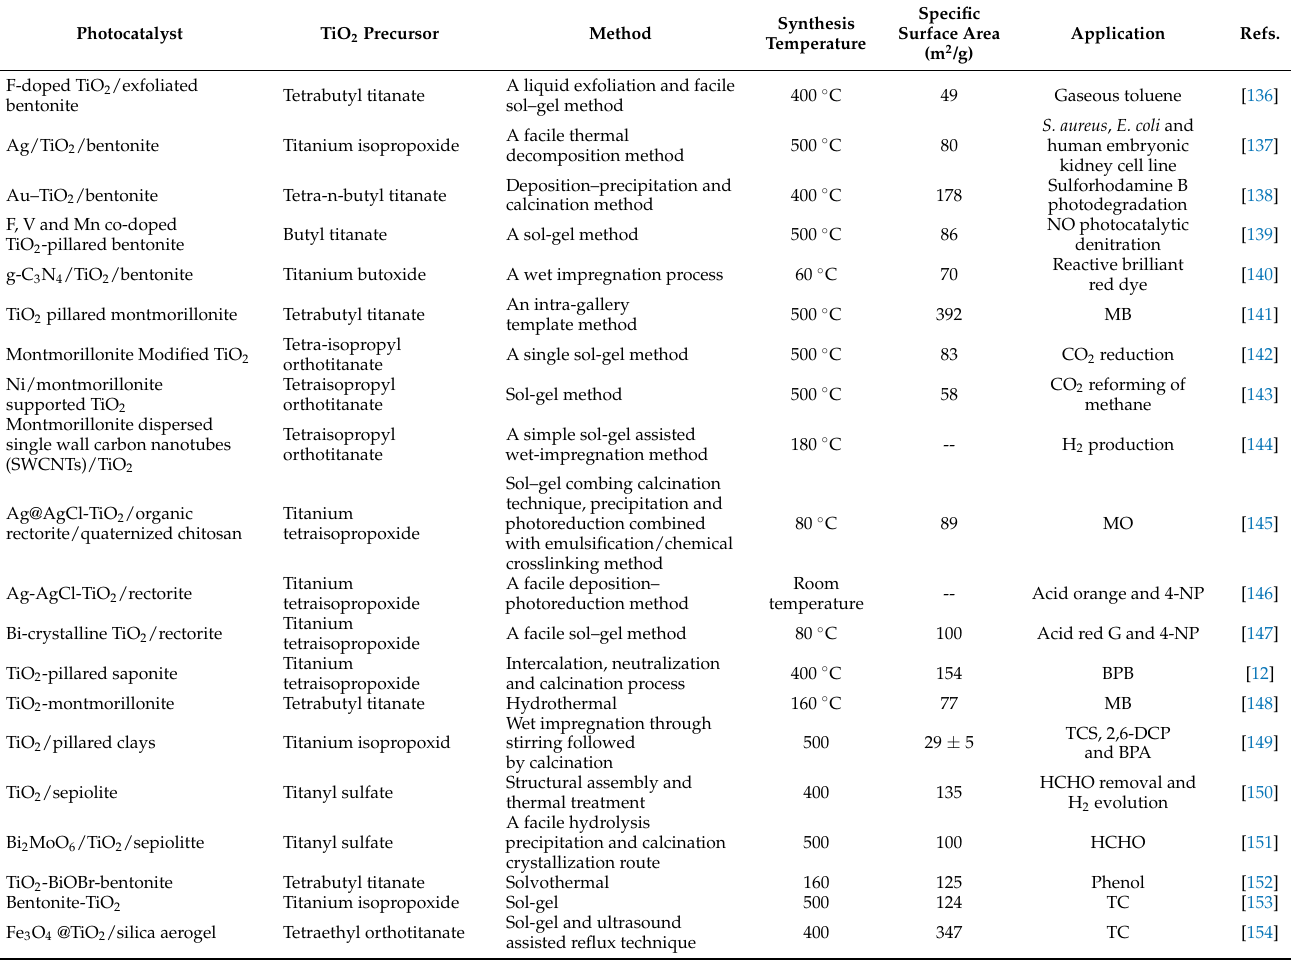
Table 2. Synthesis methods using natural smectite minerals as TiO 2